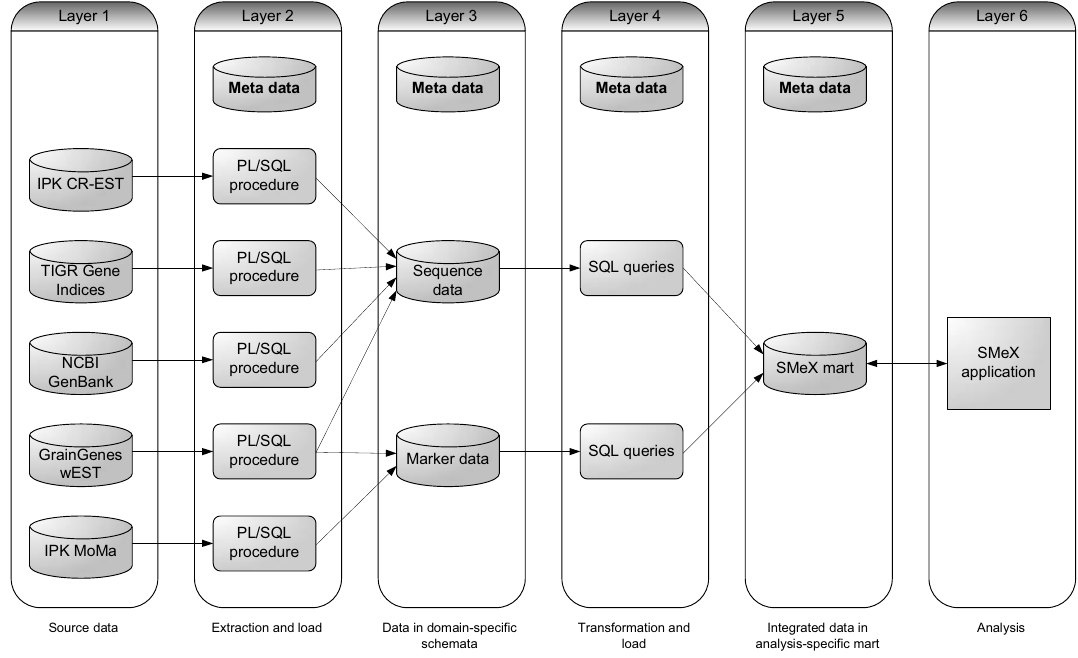
Figure 3: Implementation of our architecture for the SMeX